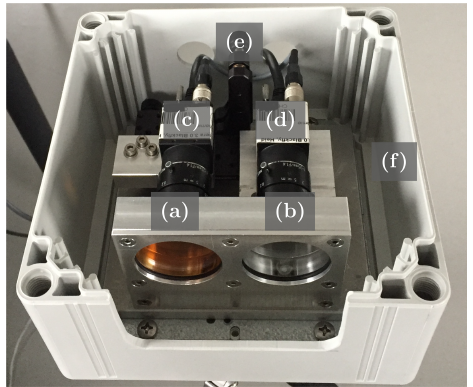
Figure 1. Photograph of the GCS-based NO 2 camera. The main parts of the instrument (see also Fig. 2a and b) are two gas cells, one filled with NO 2 (a) and one empty (b) , as well as two camera modules (c, d) , each with a lens and a bandpass filter. One of the camera modules is placed on a mounting stage (e) , which allows for precise alignment of the optical axes. All parts are mounted into a plastic case (f)